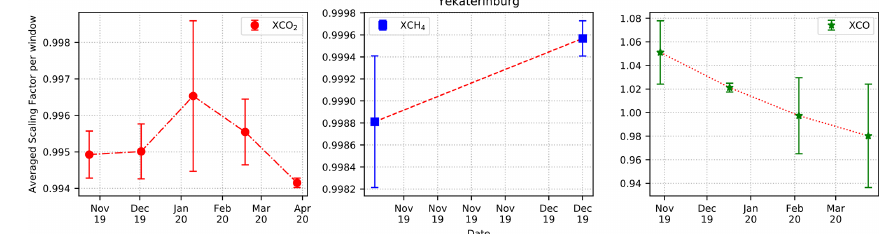
Figure A8. Same as Fig. A7 but for